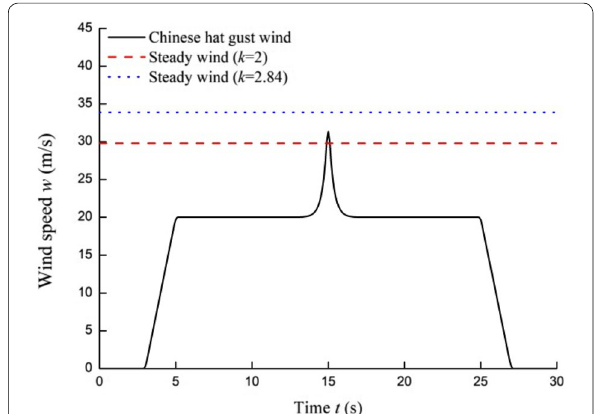
Figure 8 Comparison of turbulent wind and gust wind